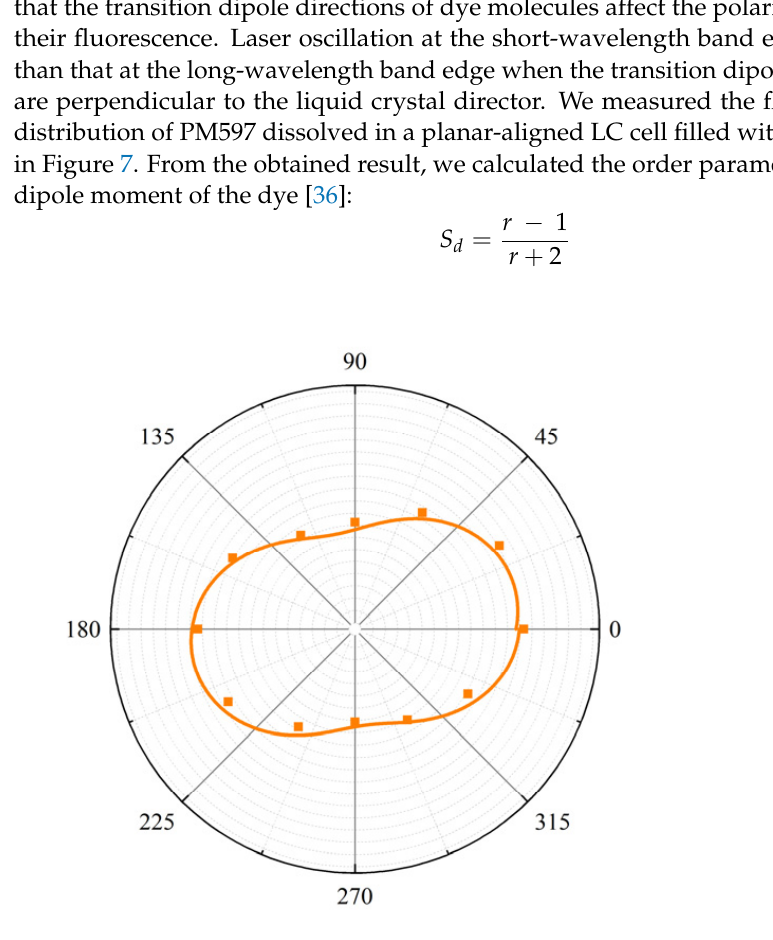
Figure 7. Dichromatic fluorescence spectrum of PM597 dissolved in a planarly aligned LC cell of pure E7 as a function of the angle between the polarizer and the rubbing direction.